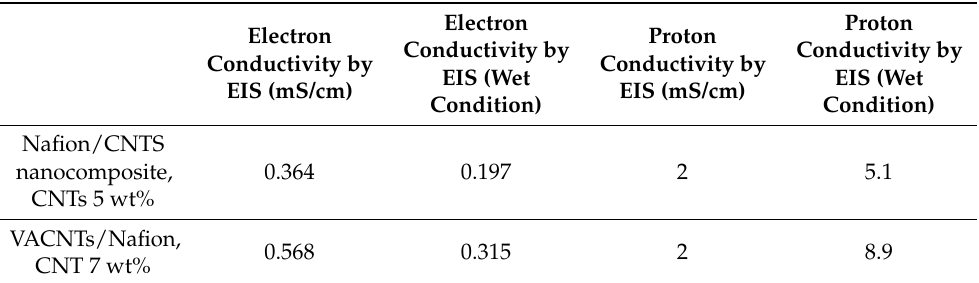
Table 3. Proton and electron conductivities obtained under different conditions for Nafion/CNT nanocomposites vs. vertically aligned-CNT/Nafion membranes (Reproduced with permission from Elsevier; adapted from Tortello et al., 2012